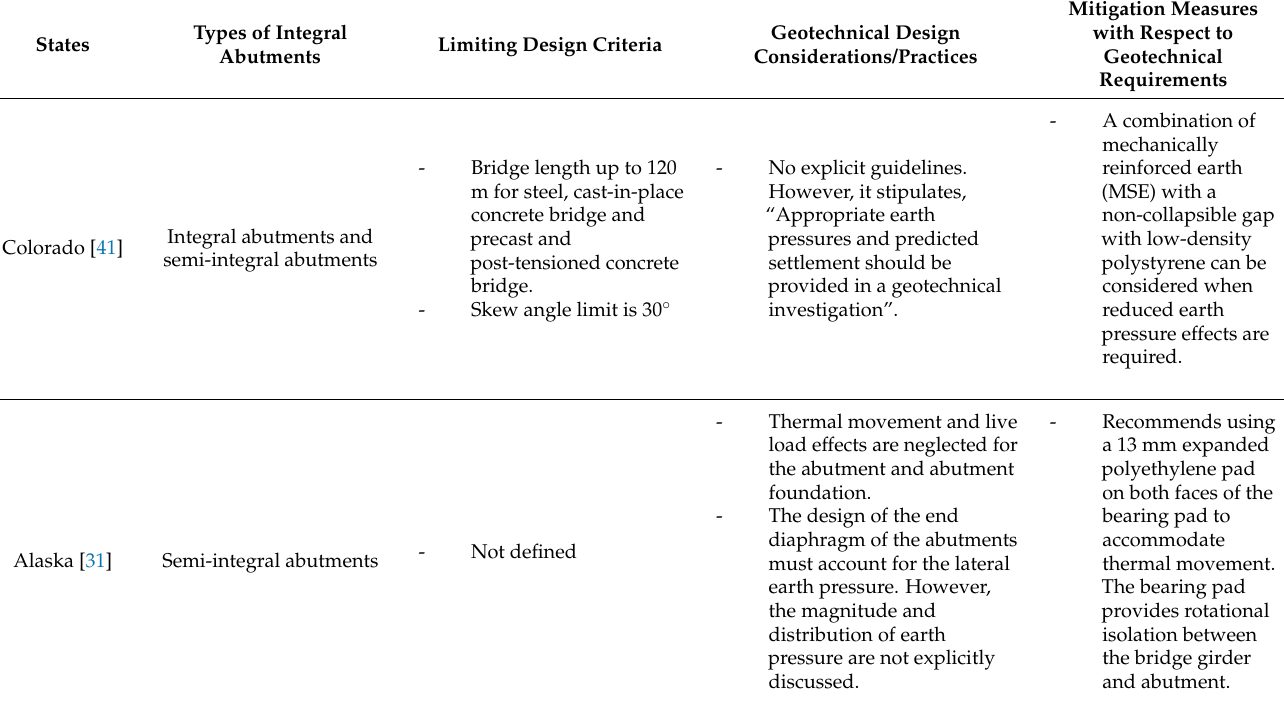
Table A1. Integral bridge practices in USA